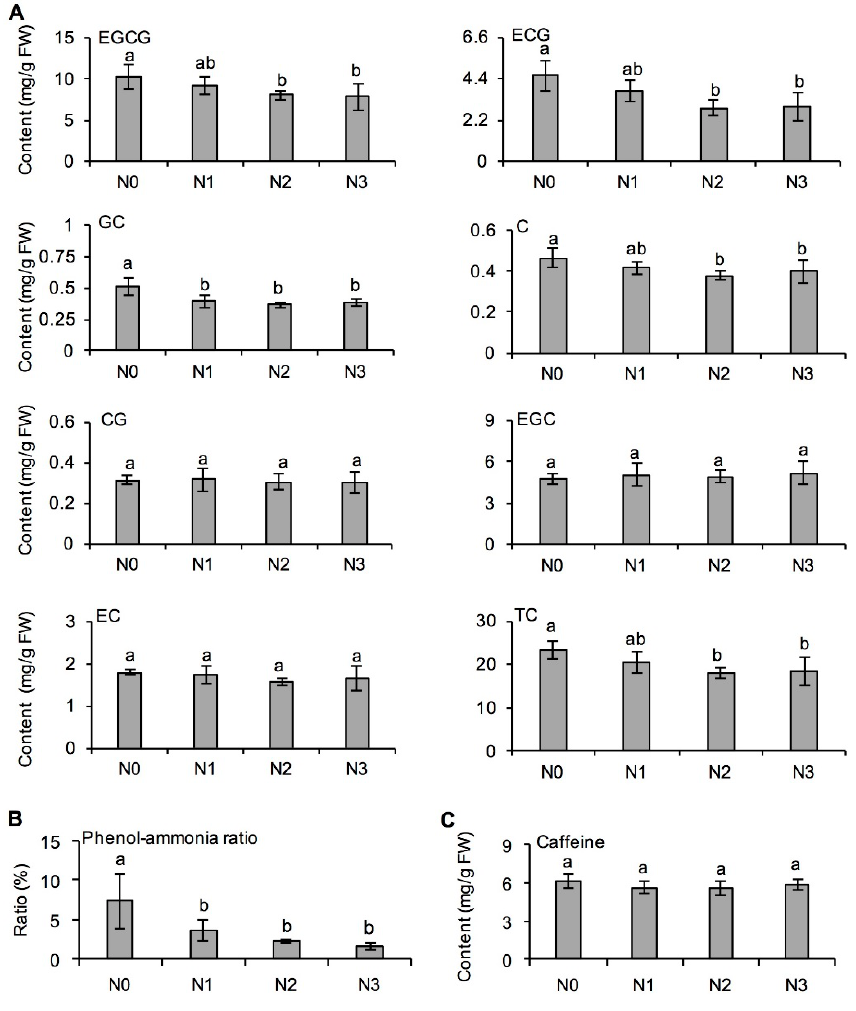
Figure 3. Effects of long-term nitrogen application on catechin content ( A ), phenol–ammonia ratio ( B ), and caffeine content ( C ) in fresh tea leaves collected in spring. EGCG: epigallocatechin gallate; ECG: epicatechin gallate; GC: eallocatechin; C: catechin; CG: catechin gallate; EGC: